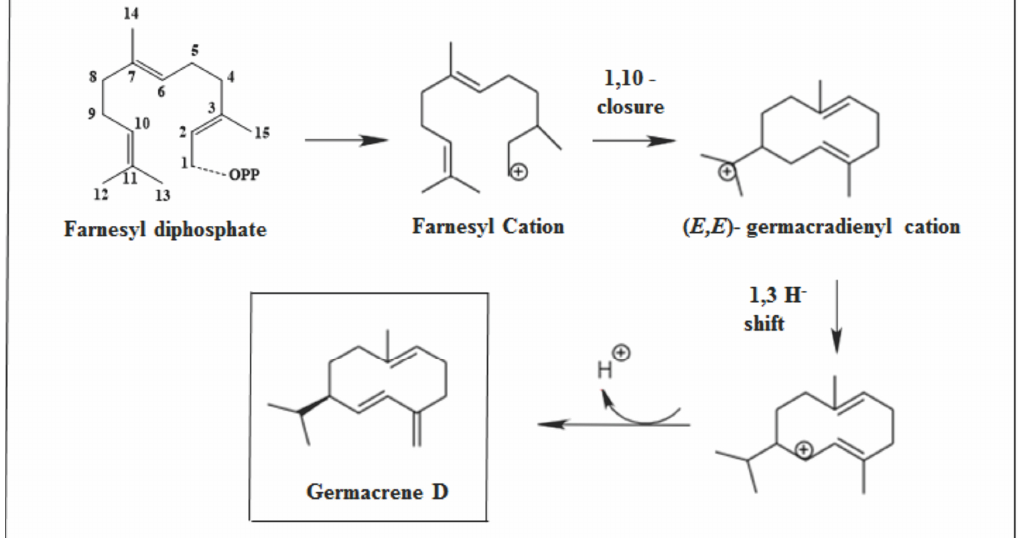
Figure 6. A type of primary cyclization of germacrene